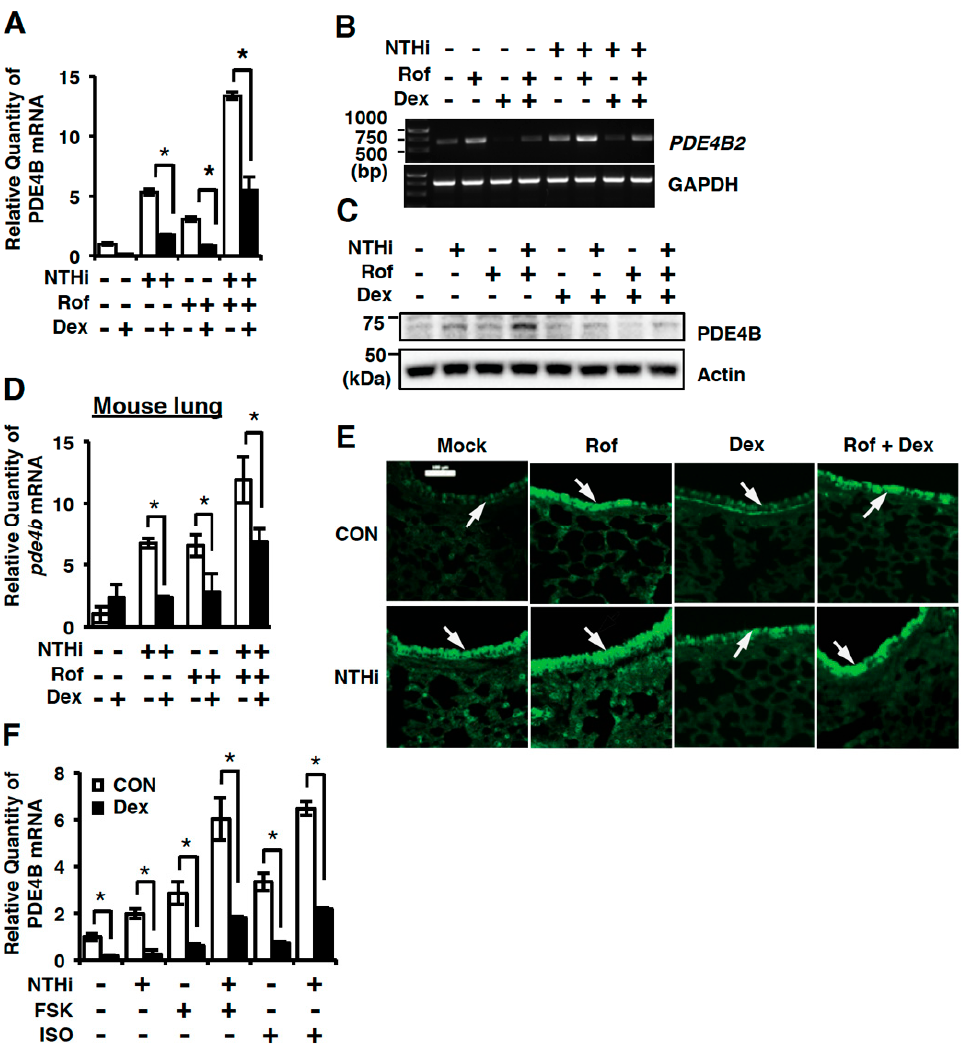
Figure 1. Dexamethasone suppresses up-regulation of phosphodiesterase 4B (PDE4B) expression by roflumilast and NTHi in vitro and in vivo. ( A ) BEAS-2B cells were pretreated with Roflumilast (Rof) (0.1 µ M) and dexamethasone (Dex) (10 nM) for 1 h followed by 1.5 h stimulation with NTHi, and PDE4B mRNA expression was analyzed by Q-PCR. Data are mean ± S.D. ( n = 3); * p < 0.05. ( B ) BEAS-2B cells were pre-treated with Rof (0.1 µ M) and dexamethasone (Dex) (10 nM) for 1 h followed by 1.5 h stimulation with NTHi, and PDE4B2 mRNA expression was analyzed by semi-quantitative RT-PCR. ( C ) BEAS-2B cells were pre-treated with Rof (0.1 µ M) and Dex (10 nM) for 1 h followed by 5 h stimulation with NTHi, and PDE4B protein expression was analyzed by western blot. ( D , E ) Mice were inoculated with Rof (5 mg/kg i.p.) and/or Dex (2 mg/kg i.p.) for 2 h, followed by intratracheal inoculation with NTHi (5 × 10 7 CFU/lung). ( D ) After 5 h, mRNA expression in lung tissues was analyzed by Q-PCR. Data are mean ± S.D. ( n = 3); * p < 0.05. ( E ) Lung tissues were stained against PDE4B (Magnification × 200, Scale bar, 100 µ m). Arrows indicate bronchial epithelium of mouse lung tissues. ( F ) BEAS-2B cells were pre-treated with forskolin (FSK) (1 µ M), Isoproterenol (ISO) (1 µ M) and Dex (10 nM) for 1 h followed by 1.5 h stimulation with NTHi, and mRNA expression was analyzed by Q-PCR. Data are mean ± S.D. ( n = 3); * p < 0.05. All the relative quantity of mRNA is relative to a house keeping gene cyclophilin or GAPDH . Data are representative of three independent experiments.